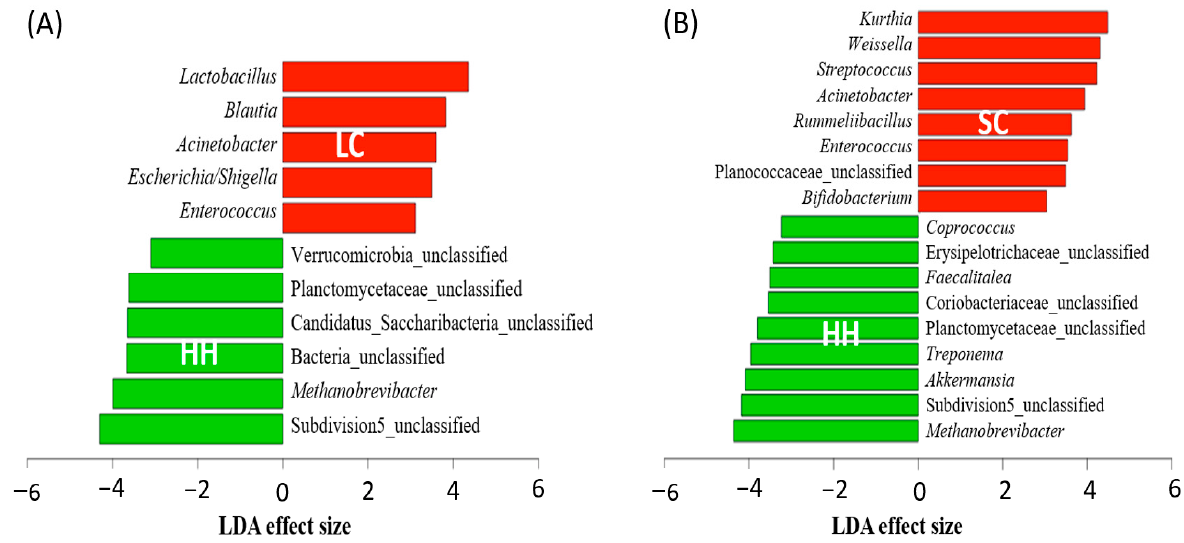
Figure 4. Differentially abundant genera in horse fecal microbiota among LC ( A ) and SC ( B ) compared to HH. HH, healthy horses; LC, horses with large intestinal colic; SC, horses with small intestinal colic.